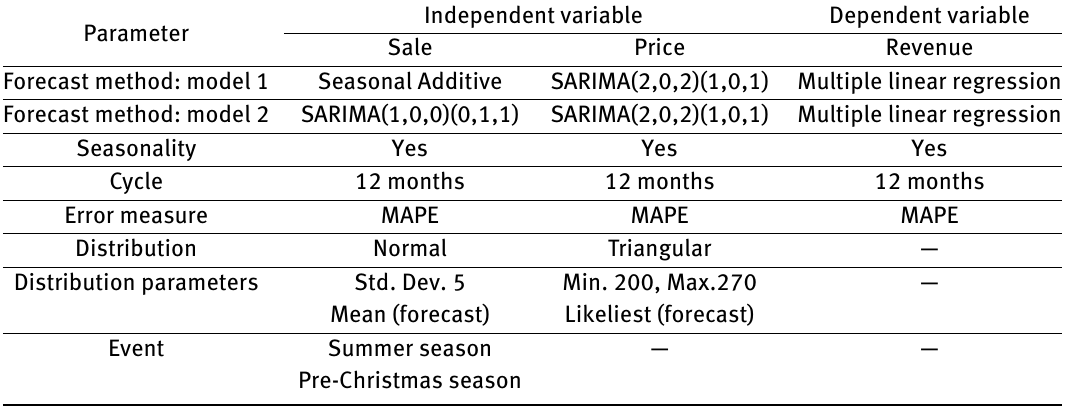
Table 3: Forecast and simulation settings.